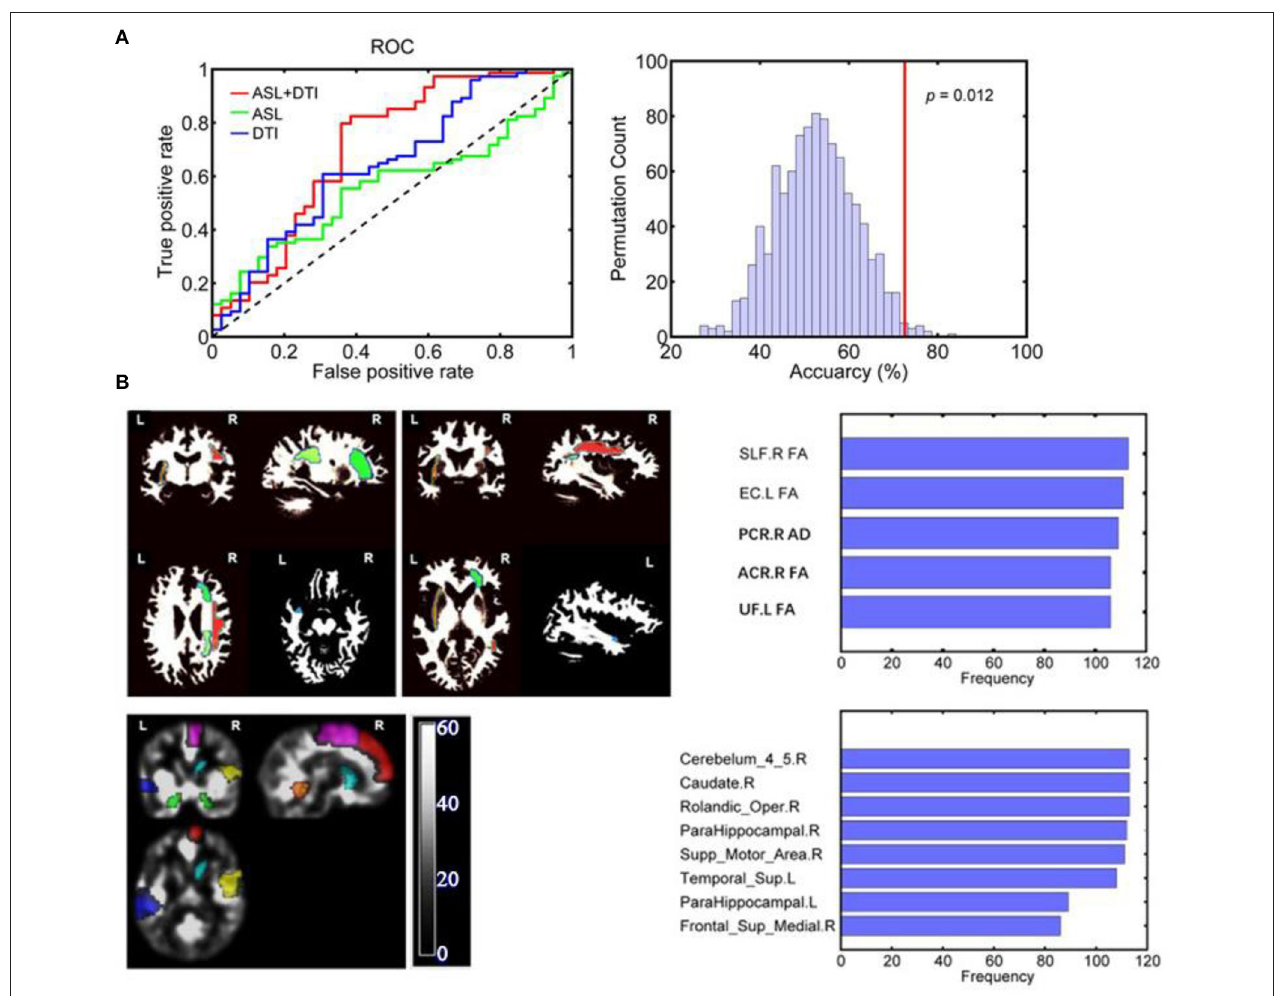
FIGURE 2 | (A) ROC curves of each SLR classifier for discriminating vMCI and controls: The AUC for the combined model, a single ASL model, and a single DTI model were 0.708, 0.559, and 0.647, respectively. (B) The discriminative gray and white matter regions for SLR classifier based on combined features. The combined CBF areas included Rolandic_oper, Supp_Motor_Area, Frontal_Sup_Medial, ParaHippocampal and Caudate of the right hemisphere as well as ParaHippocampal and Temporal_ Sup in the left hemisphere. The combined DTI features included ACR_FA, PCR_AD, and SLF_FA of the right hemisphere as well as EC_FA and UF_FA in the left hemisphere. SLF, superior longitudinal fasciculus; EC, external capsule; ACR, anterior corona radiata; PCR, posterior corona radiata; UF, uncinate fasciculus; L, left; R,